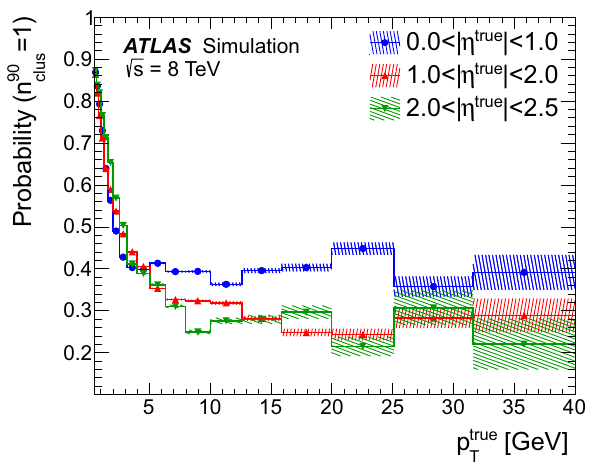
Fig. 6 The probability that a single topo-cluster contains > 90% of the true deposited energy of a single charged pion, which deposits sig- nificant energy (20% of the particle’s energy) in the clustered cells. The distributions are shown as a function of p true in three | η true | T regions. The data are taken from a dijet sample without pile-up with < 500GeV and the statistical uncertainties on the number 20 < p lead T of MC simulated events are shown as a hatched band